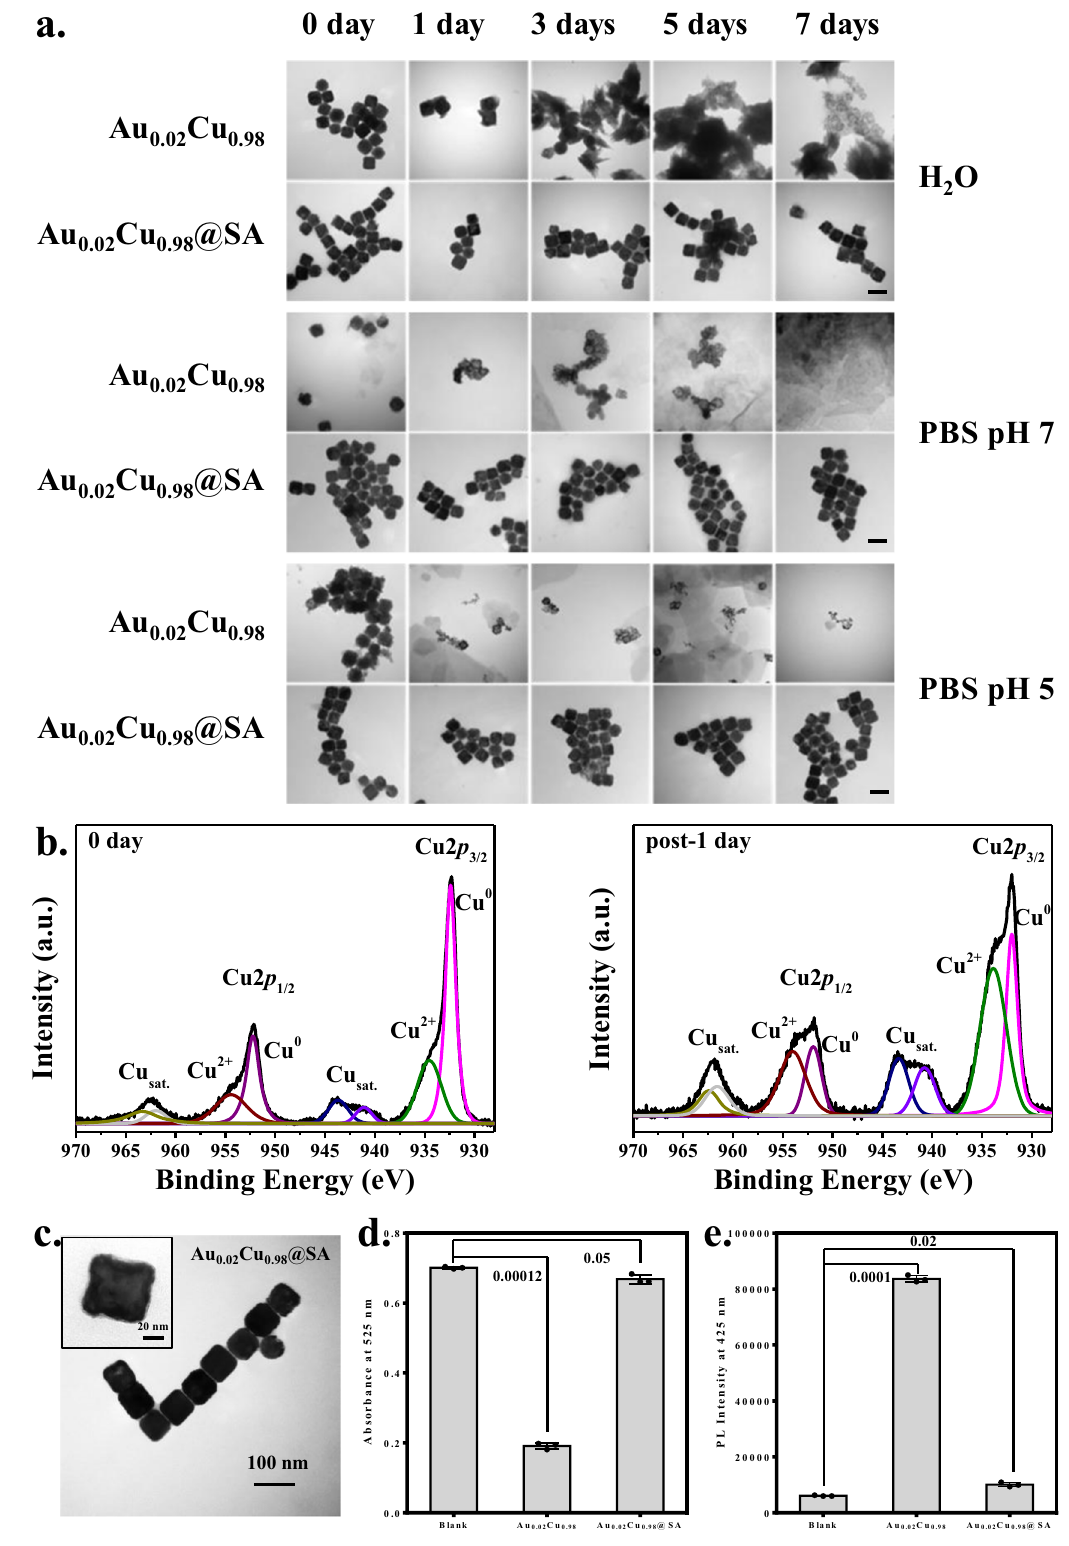
Figure 4e – h shows the electron localization function (ELF) dia- accumulate more to the gold atoms from Au 0.02 Cu 0.98 to Au 0.5 Cu 0.5 (Fig. 4b and c). For the pure Au (Fig. 4d), the ELF plot displays the grams of the pure Cu, Au 0.02 Cu 0.98 , Au 0.5 Cu 0.5 , and pure Au. The electronslocatearoundthehollowpositionbetweenthecopperatoms electron localization around the gold atoms rather than at the hollow on the pureCu (Fig. 4e),re fl ecting the strong activity of the hollow site region. Since the electronegativity of Au is larger than the Cu, the for the pure Cu. On the other hand, the electron localization around charge of the Au atoms can become more negative in the Au/Cu 0 nanocubes. According to previous theoretical studies 27,28 , increased the hollow site becomes weaker while the electrons begin to